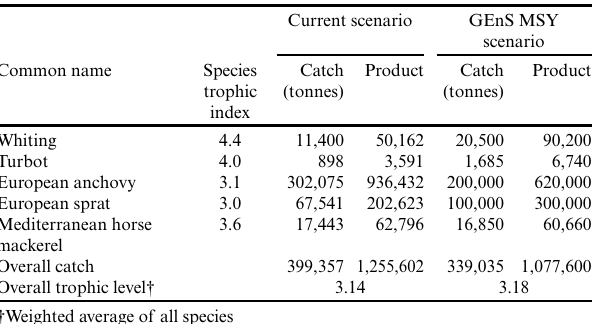
Table 4 . Trophic index of five Black Sea stocks under current and Good Environmental Status (GEnS) scenarios. (MSY = maximum sustainable yield)